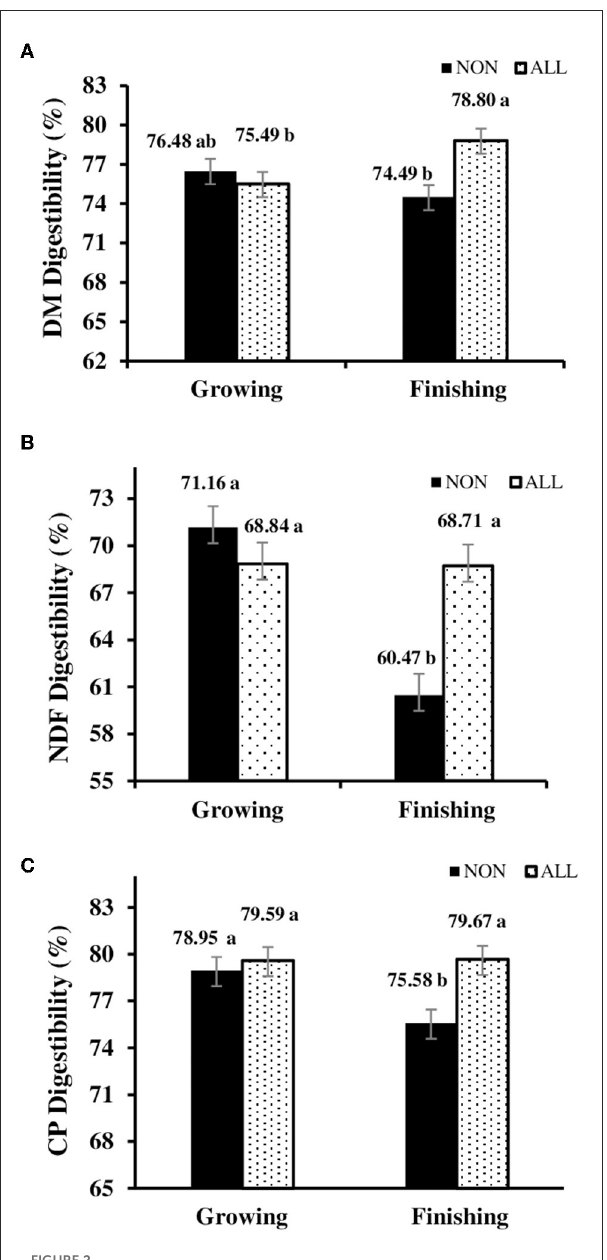
FIGURE2 Feeding phase × digestibility interaction [ (A) dry matter digestibility; (B) NDF digestibility; (C) crude protein digestibility] of electronically monitored Bos indicus influenced bullocks during growing and finishing feeding period. NON, Control; ALL, Lysoforte supplementation in all phases (since adaptation); within column, different superscripts differ in LSMEANS at P ≤ 0.05.